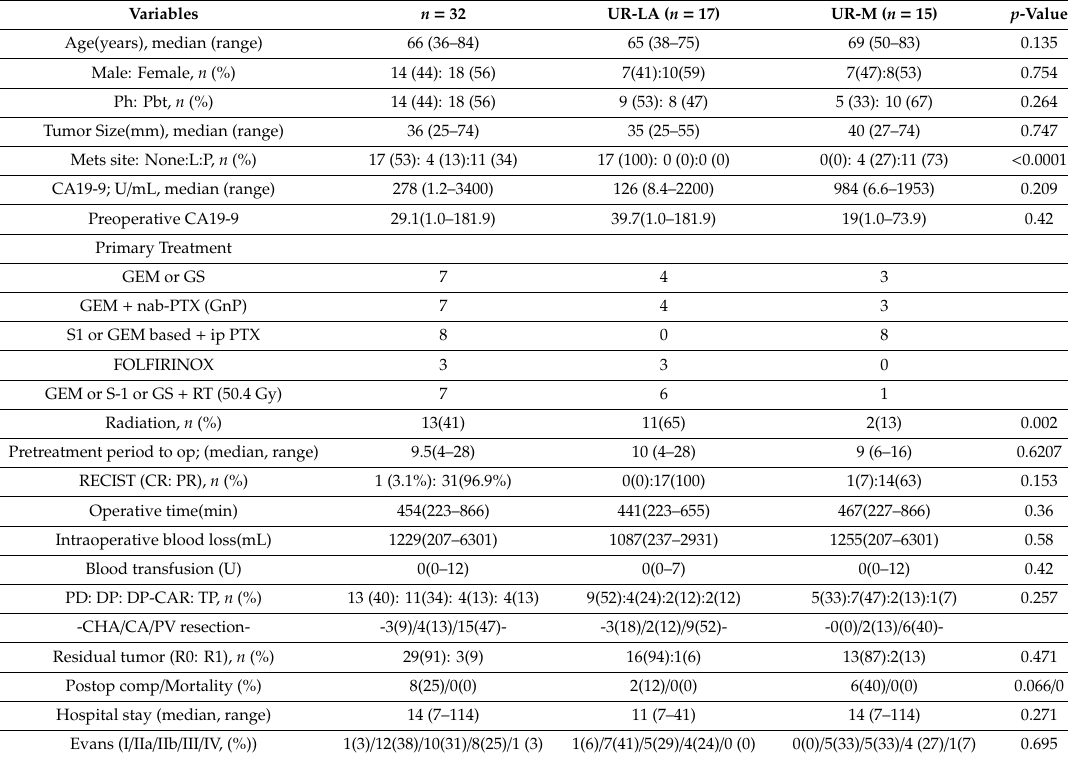
Table 2. Patient characteristics of conversion